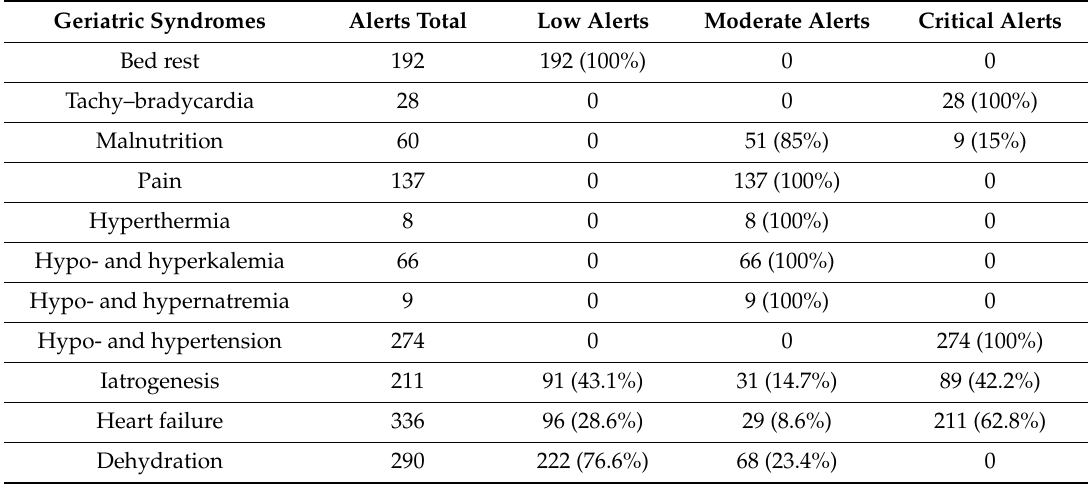
Table 7. Total alerts emitted per risk group and geriatric risk (“low”, “medium”, and “critical”). Geriatric Syndromes Alerts Total Low Alerts